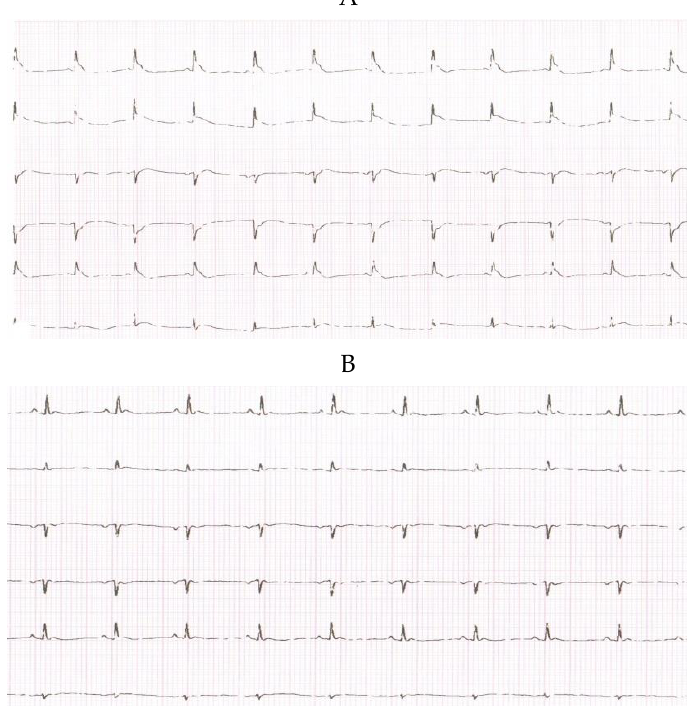
Figure 6. Representative ECG recording . Representative ECG recording of a sham operated Wistar Kyoto rat (6A) and a WKY rat with experimentally induced myocardial infarction (6B).